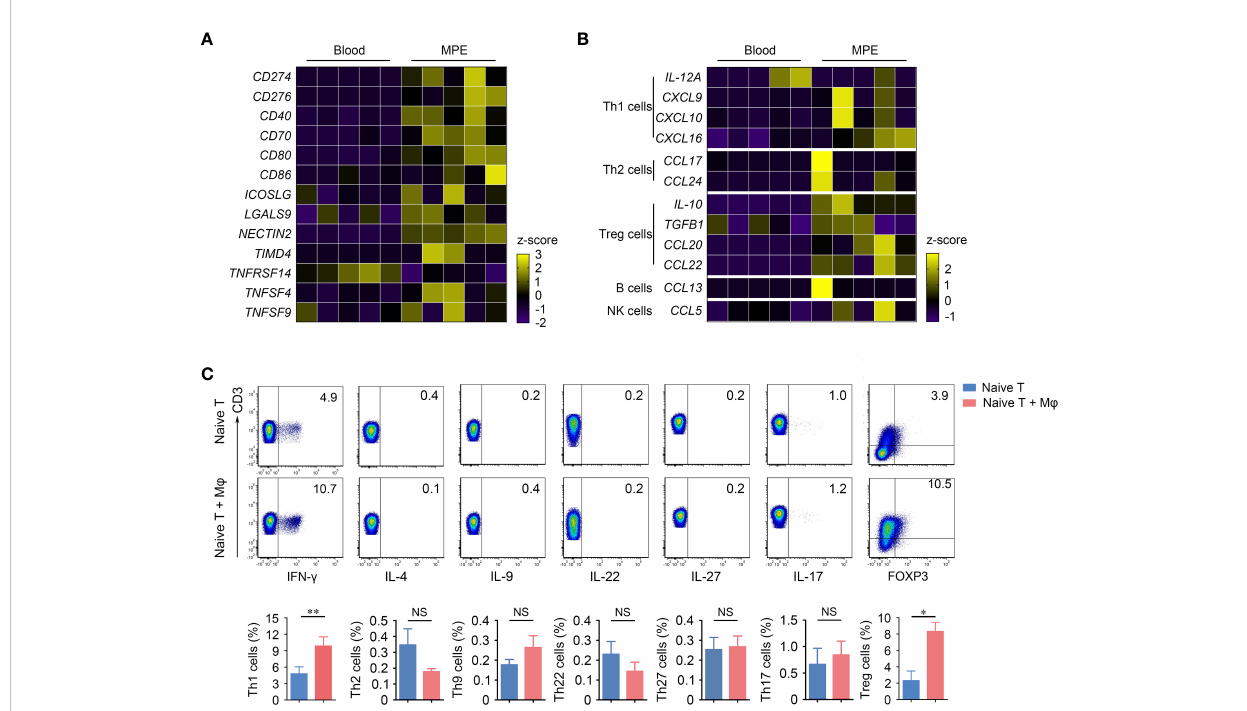
FIGURE 2 M j s in MPE interact with T cells and promote the differentiation of Th1 cells and Treg cells. (A) Heatmap shows the lymphocyte costimulatory molecule pro fi le of M j s in MPE and blood. (B) Heatmap shows the cytokine and chemokine pro fi le of M j s in MPE and blood. (C) Representative fl ow cytometry plots of Th1 cells, Th2 cells, Th9 cells, Th22 cells, Th27 cells, Th17 cells and Treg cells are shown from one of three independent experiments (upper panel). Comparisons of percentages of these cells are shown in the bottom panel. Data are presented as mean ± SEM. Comparisons were made using Student ’ s t test. * P < 0.05, ** P < 0.01. NS, not signi fi